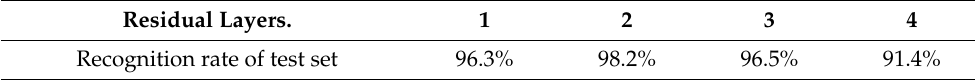
Table 1. Recognition rate for different numbers of residual layers. Residual